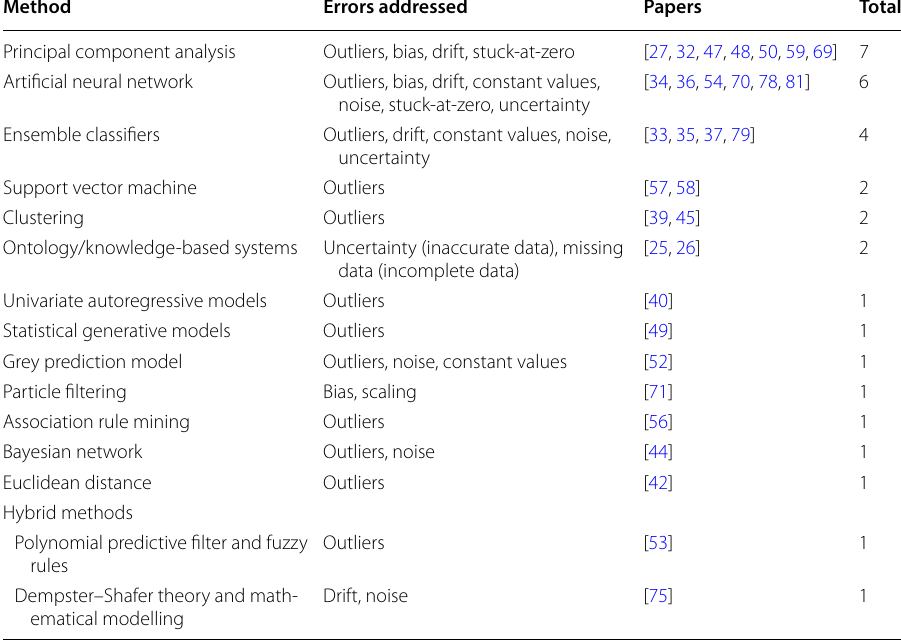
Table 3 Types of methods addressing error detection and quantification (RQ2) only, along with its addressed errors, respective papers, and the total number of papers that proposed that